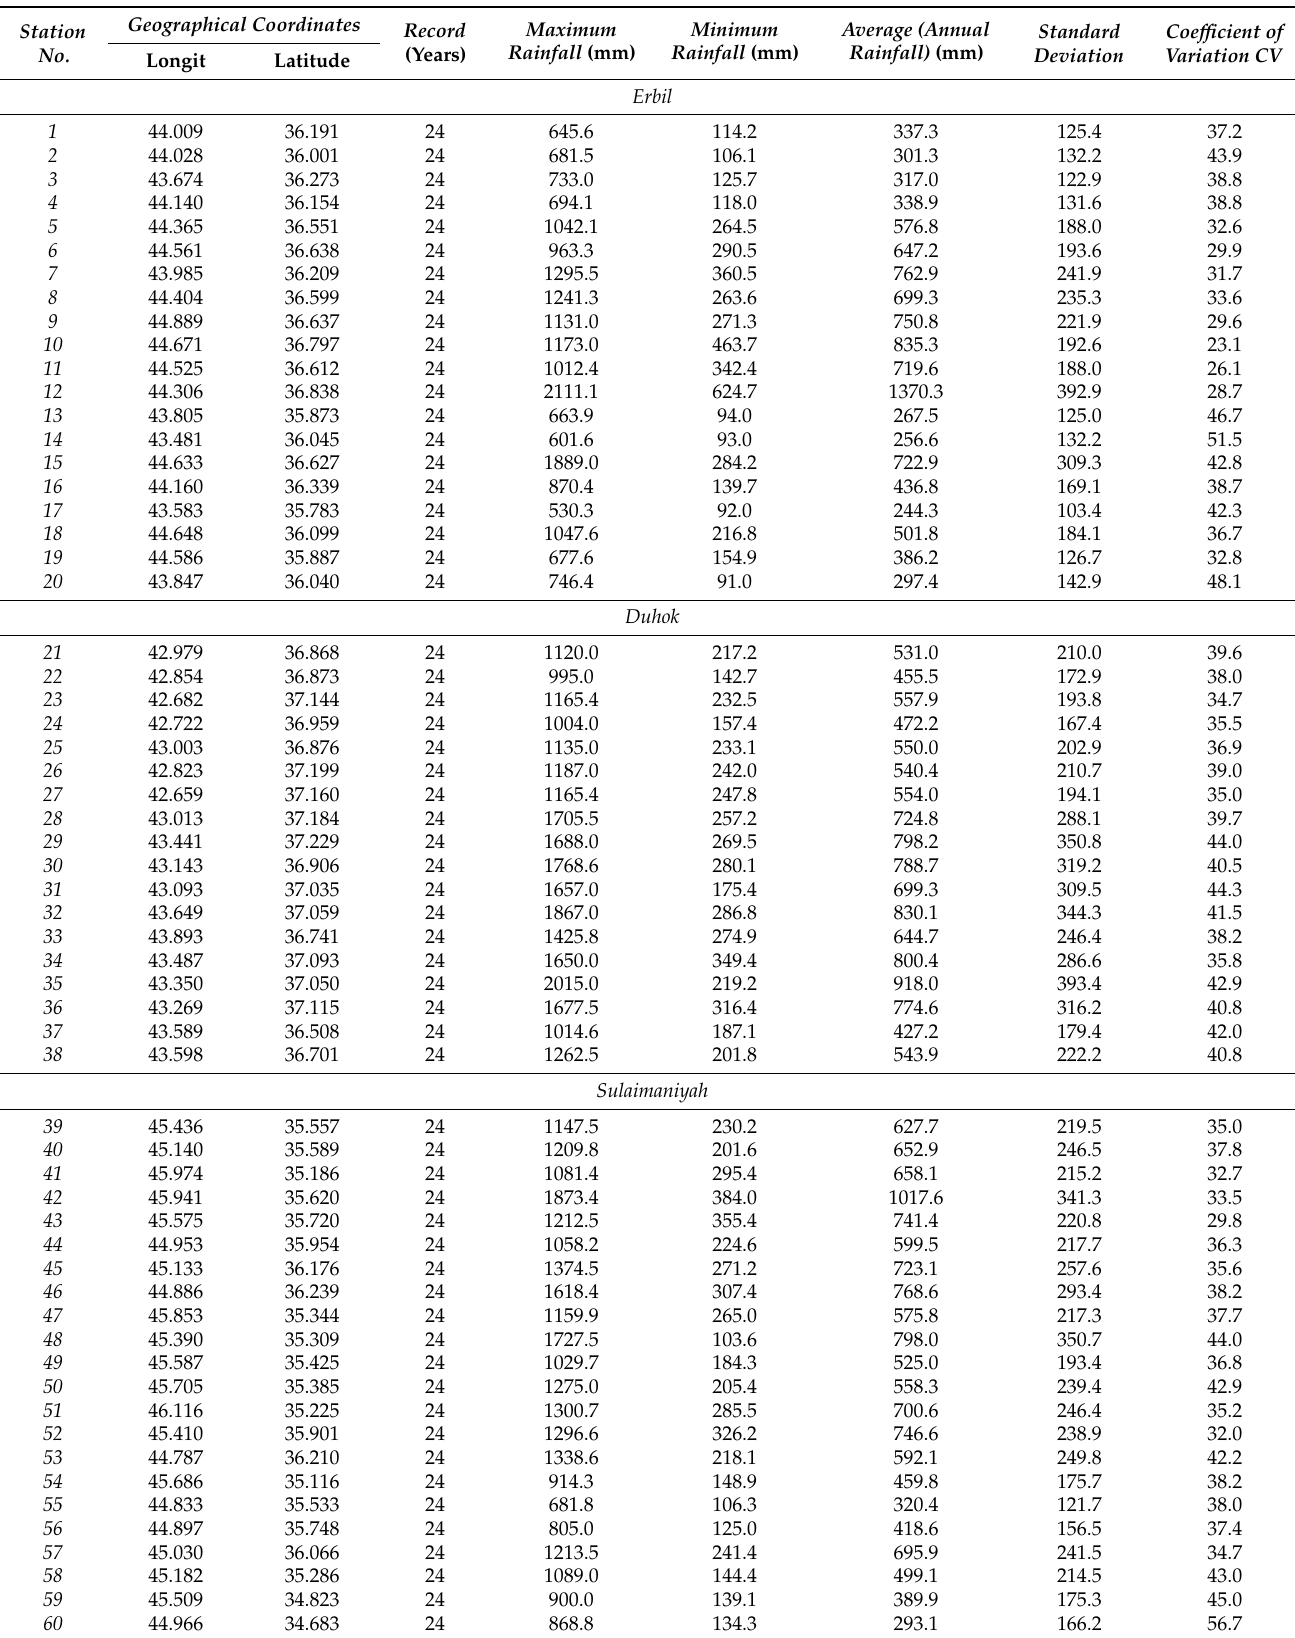
Table 5. Descriptive statistics of the annual precipitation series data recorded at each of the 60 weather